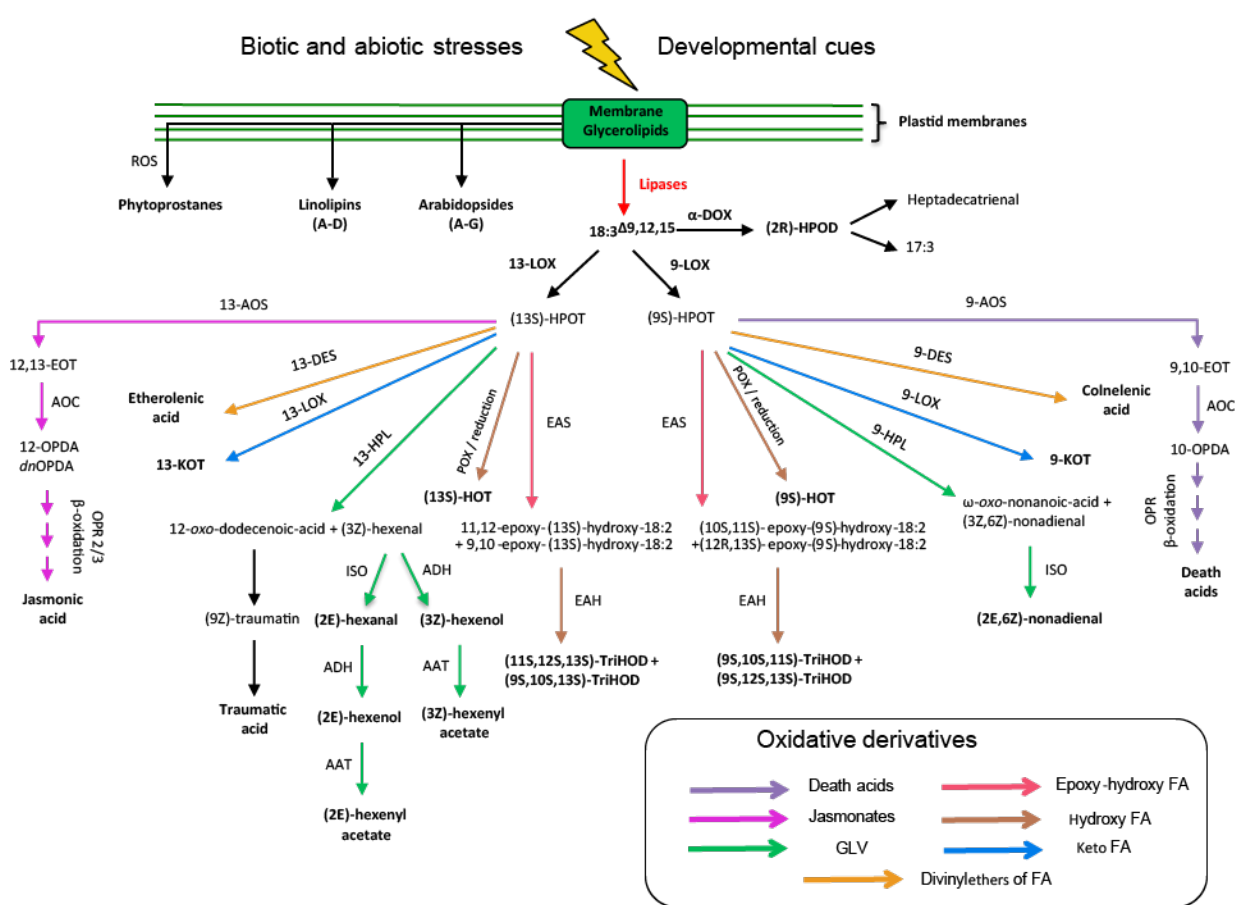
Figure 3. Overview of derivatives oxidized from alpha-linolenic acid. Following environmental stress or developmental cues, alpha-linolenic acid from plastid membrane glycerolipids is released by plastid lipases to be converted into multiple compounds within the metabolism of oxylipins. α-dioxygenases catalyze the formation of unstable hydroperoxide, which are quickly converted to shorter-chain fatty acids or aldehyde, while lipoxygenases catalyze the formation of hydroperoxides, which will serve as precursors for a large set of oxygenate compounds. This library of compounds includes the family of jasmonates (magenta arrows), death acids (purple arrows), green leaf volatiles (green arrows), epoxy–hydroxy fatty acid (pink arrows), hydroxy fatty acid (brown arrows), keto fatty acids (blue arrows) and divinyl ethers of fatty acids (orange arrows). List of abbreviations in alphabetical and numerometric order: (2R)-HPOD, unstable hydroperoxyde; 9-AOS, 9-allene oxide synthase; 9-DES, 9-divinyl ether synthase; 9-HPL, 9-hydroperoxide lyase; 9-LOX, 9-lipoxygenase; 9,10-EOT, 9,10-epoxyoctadecatrienoic acid; (9S)-HPOT, 9-hydroperoxy-10,12,15-octadecatrienoic acid; (9S)-HOT, 9-hydroperoxide lyase; 10-OPDA, 10- oxo -11,15-phytodienoic acid; 12,13-EOT, 12,13-epoxylinolenic acid; 12-OPDA, 12-oxo-10,15-phytodienoic acid; 13-AOS, 13-allene oxide synthase; 13-DES, 13-divinyl ether synthase; 13-HPL, 13-hydroperoxide lyase; 13-KOT, 13-fatty acid ketotriene; 13-LOX, 13-lipoxygenase; (13S)-HPOT, 13-hydroperoxy-10,12,15-octadecatrienoic acid; (13S)-HOT, 13-hydroperoxyde lyase; α-DOX, α-dioxygenases; AAT, alcohol acyltransferase; AOC, allene oxide cyclase; ADH, alcohol dehydrogenase; EAS, epoxyalcohol synthase; EAH, epoxy hydrolase; ISO, isomerase; OPR, oxo -phytodienoic acid reductase; POX, peroxigenase; ROS, reactive oxygen species; TriHOD, trihydroxy fatty acids.